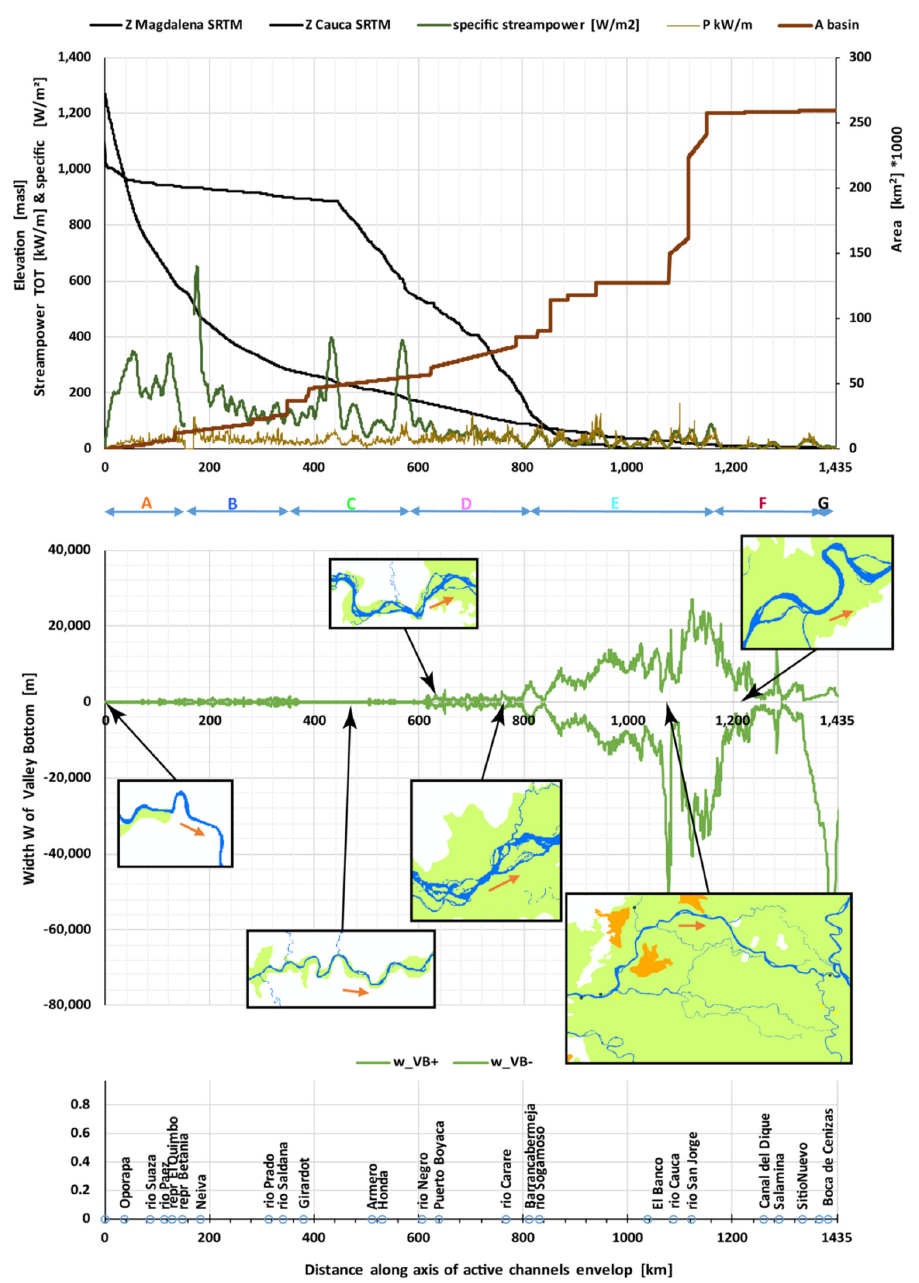
Figure 8. Synoptic scheme of the Magdalena River (including long profile Z of the main tributary Cauca) with area (A) of the contributing basin. Total (P) and specific streampower (see definition in the text) has been computed with the Q2.33 flow, estimated from empirical relationships from literature; the value shown is the moving average with a 20 “subsections” window (each “subsection” is 500 m). Notice that this figure is schematic assuming the river flows from left to right, while in physical maps the lower stretch (within the Mojana Region) flows from East to West, i.e., in the opposite direction; small planform sketches are reoriented according to the figure convention.